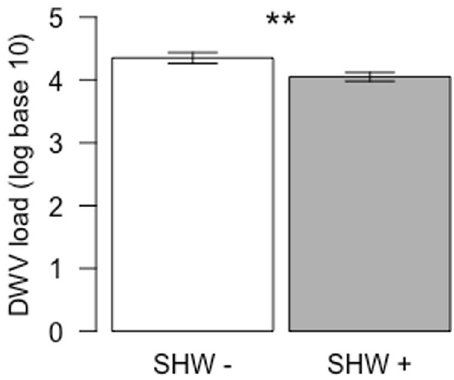
Figure 7. Deformed wing virus loads according to the SHW treatments. Mean and standard error DWV load in bees sampled at the end of an SHW − (white bars) or SHW + period (grey bars) (n = 26 pool for SHW − ; n = 25 pools for SHW + ). Significant differences between groups are indicated ( ** P < 0.01,